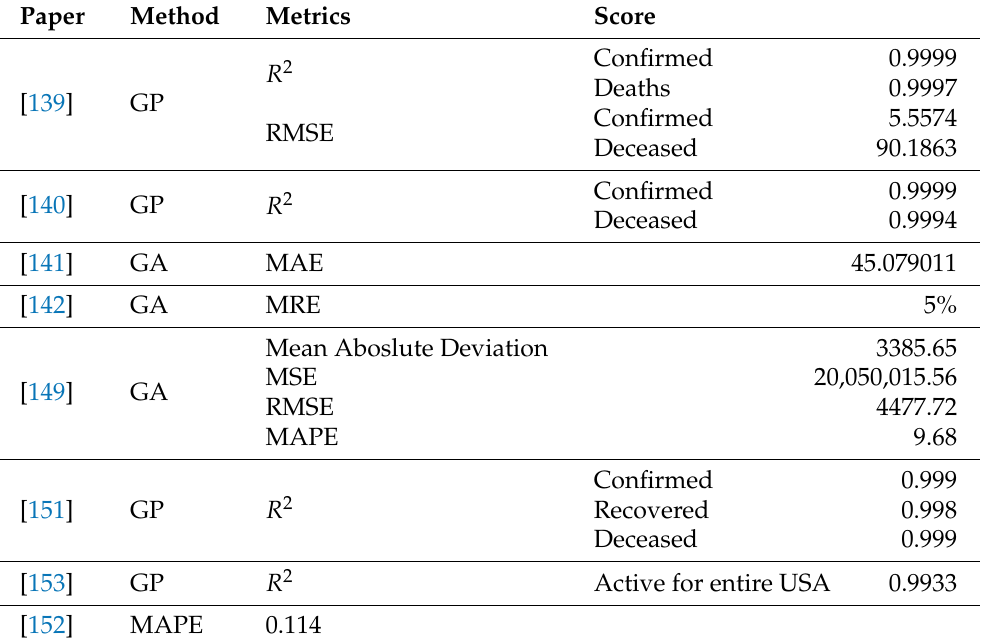
Table 7. Result comparison for EC-based